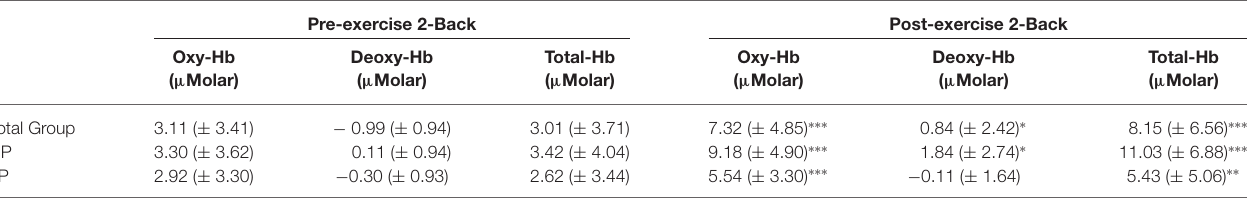
TABLE 2 | Pre- and post-exercise 2-back oxy-, deoxy, and total-Hb levels (mean ± SD) are given for total, LP and HP group in central prefrontal cortex (PFC) area. Pre-exercise 2-Back